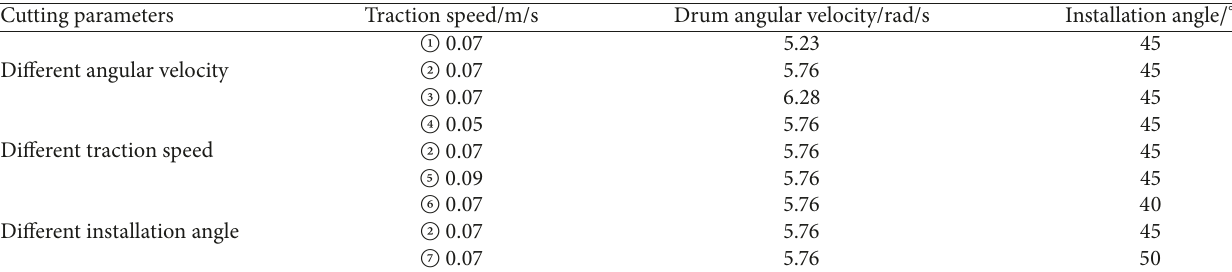
Table 1: 7 sets of various parameters.